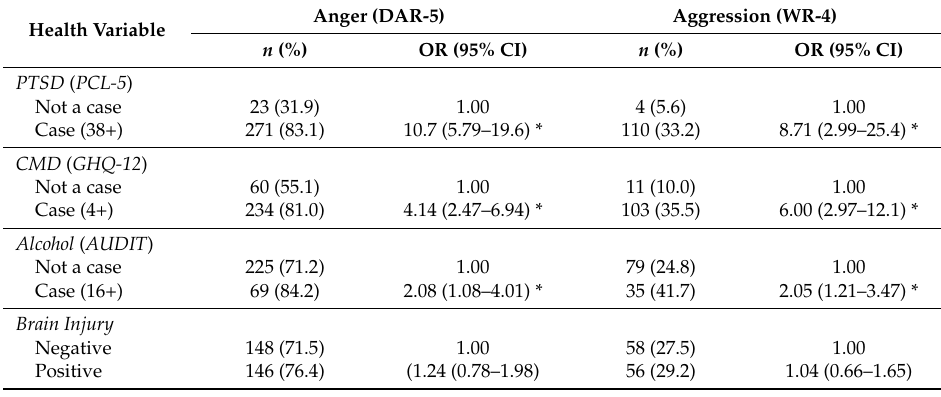
Table 3. Health factors associated with anger and aggression.